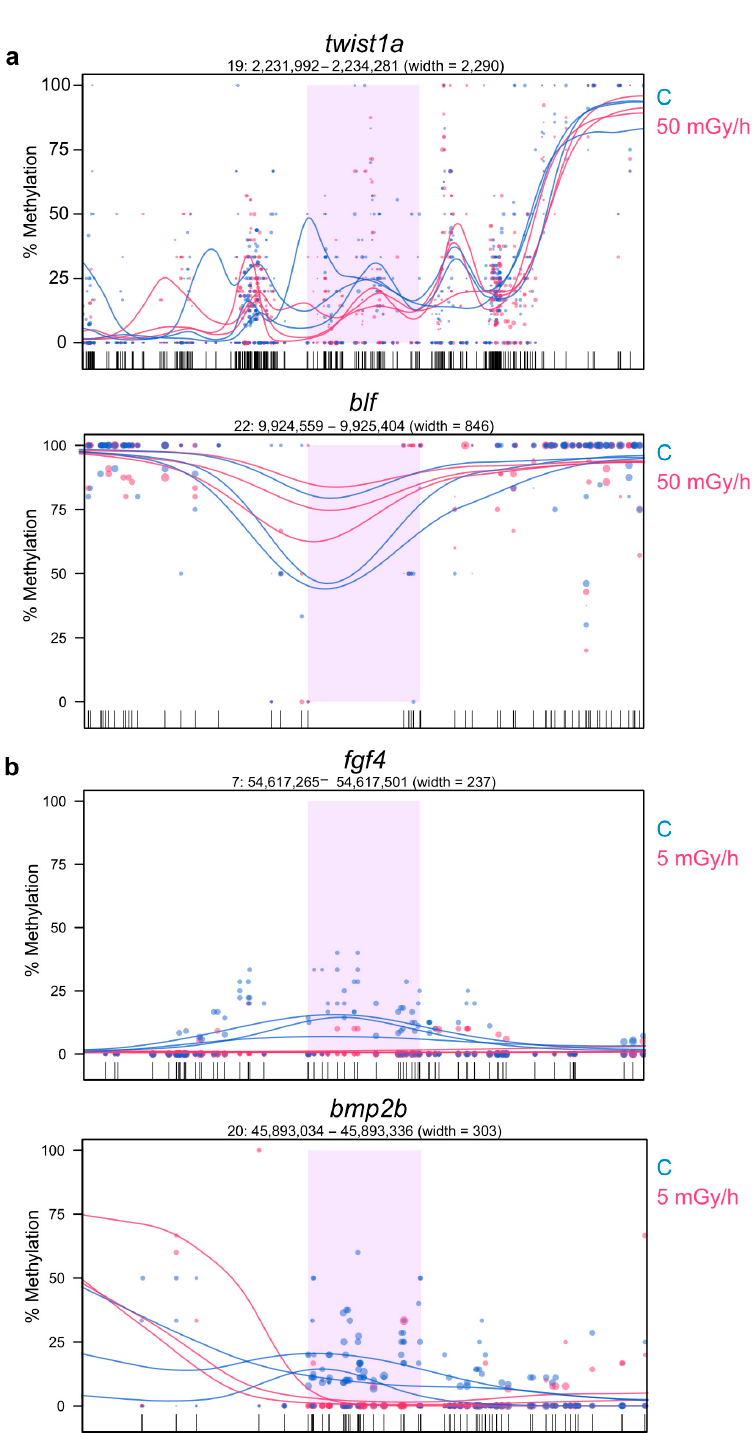
Figure 7. Example of methylation profile of DMR located in the promoter of DEG gene at ( a ) 50 mGy / h and ( b ) 5 mGy / h. The purple part corresponds to the DMR detected with significant methylation change (permutation p -value < 0.05 and methylation di ff erence ≥ 10%). The gene name and the genomic coordinated are indicated at the top. Locations of methylated CpG measured in the whole genome bisulphite sequencing (WGBS) data are indicated at the bottom by black vertical lines. Methylation of CpG appears as circles for each biological replicate with a dot size proportional to the reads coverage. The lines correspond to the model of CpG methylation level for each sample. Red: 50 or 5 mGy / h and blue: